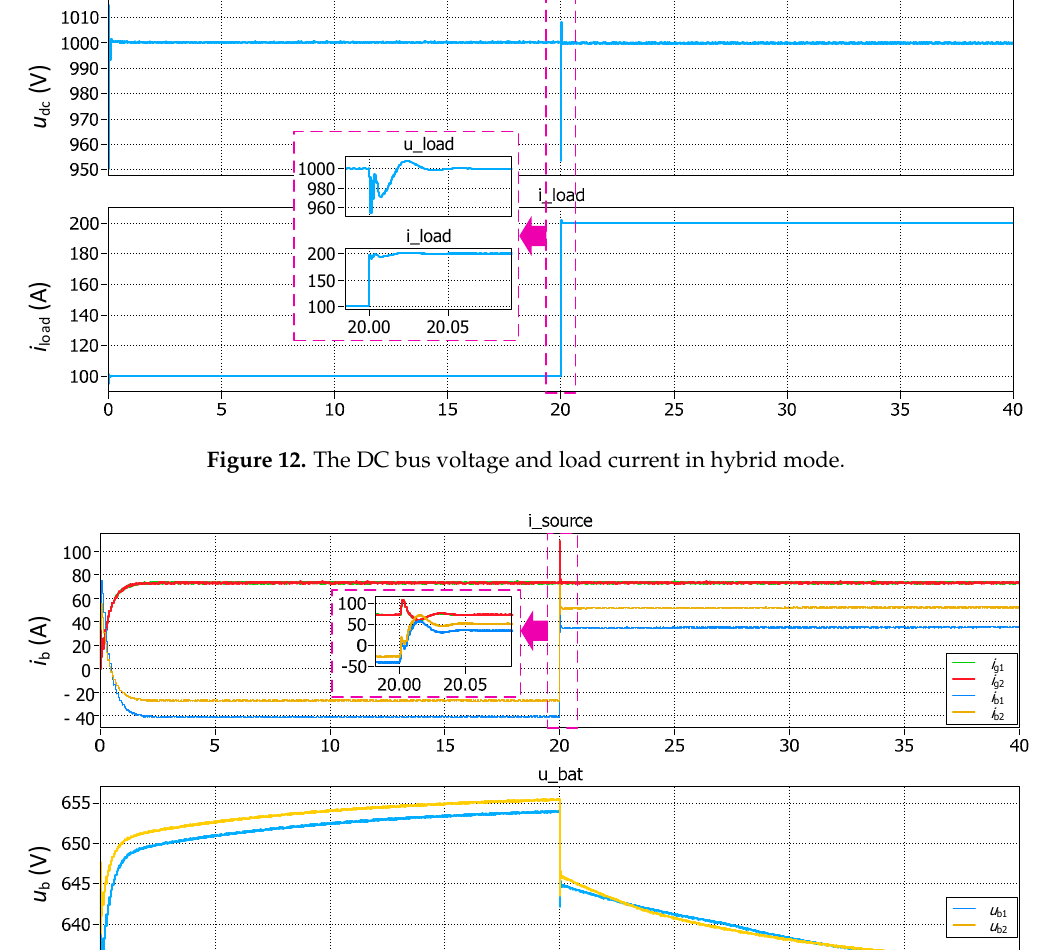
Figure 14. S oC of battery 1 and battery 2 in hybrid electric mode.